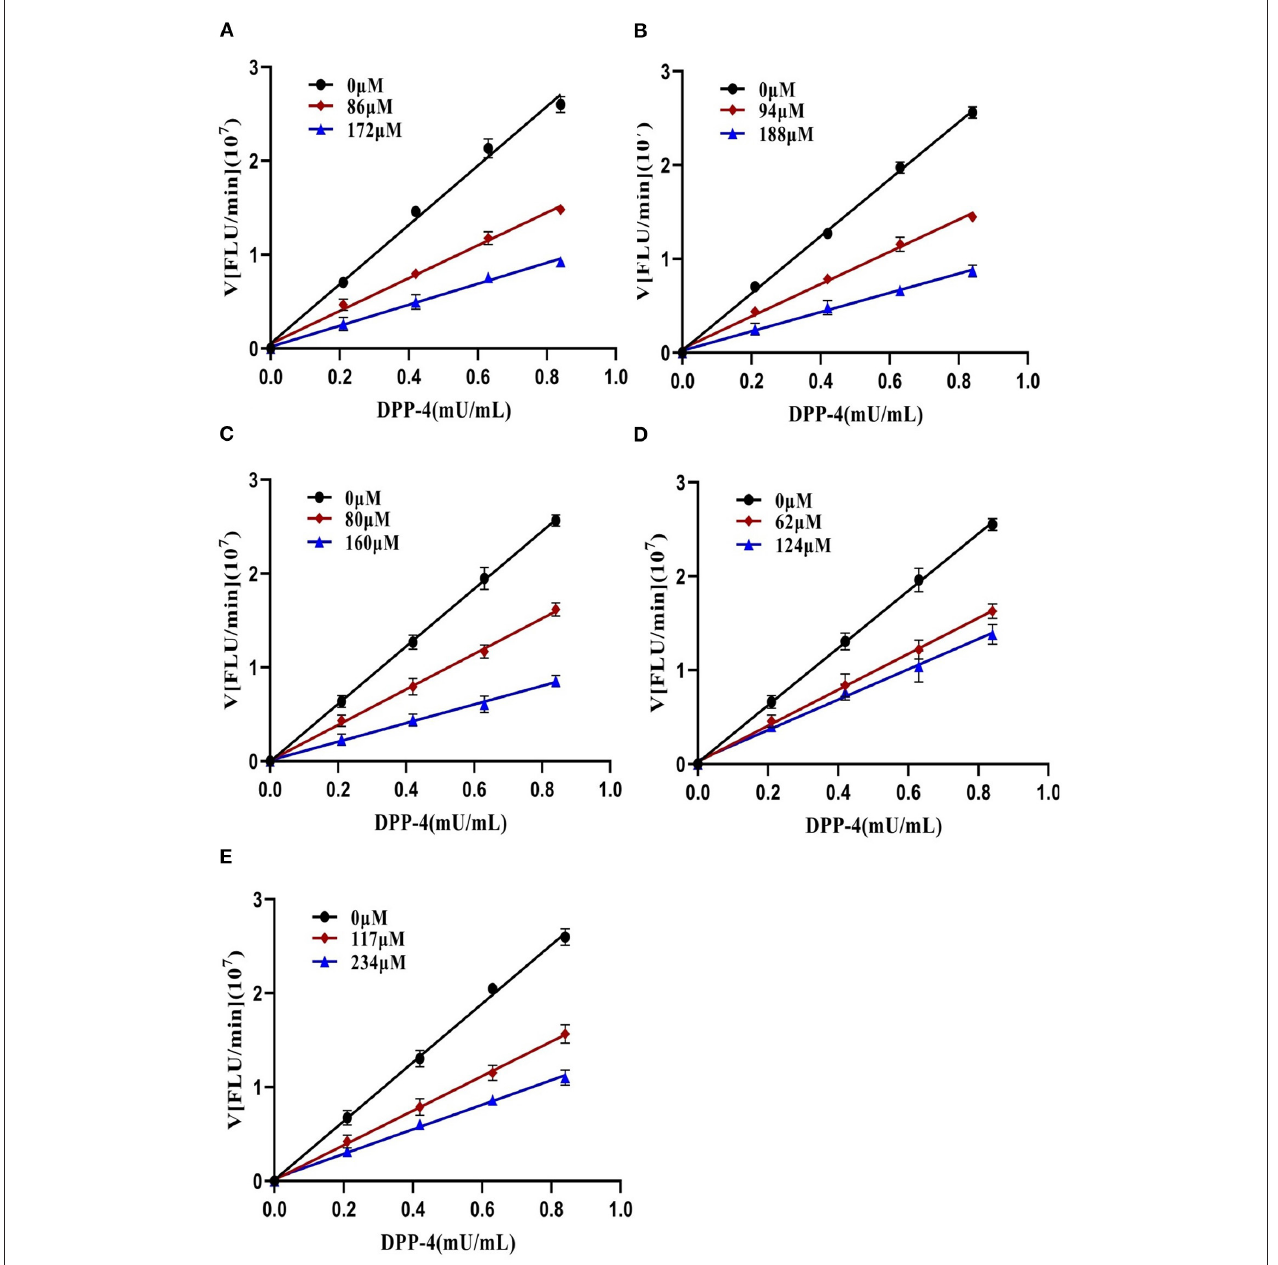
FIGURE 1 | Plots of V vs. [DPP-4] in the absence and presence of hyperoside (A) , myricetin (B) , narcissoside (C) , cyanidin 3-O-glucoside (D) , isoliquiritigenin (E) .